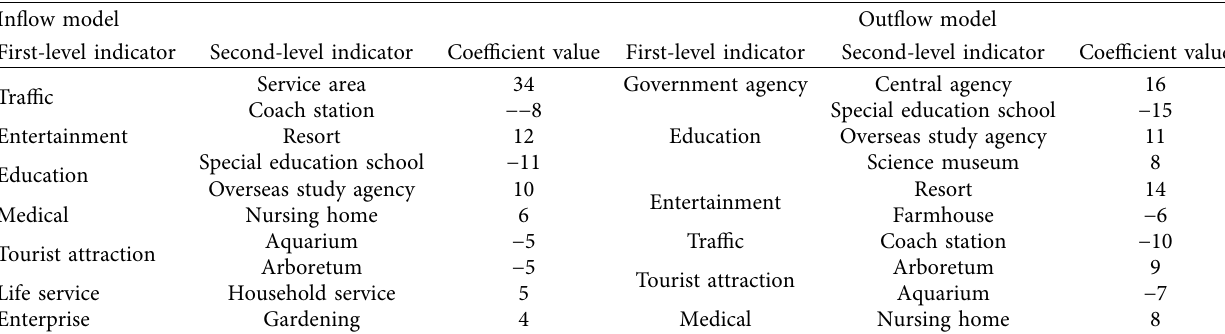
Table 13: Top 10 variables of the largest absolute value of coefficient in model during rush hours in the evening. Inflow